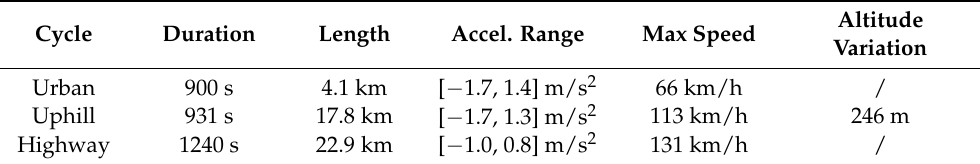
Figure 5. Speed profile of the highway real ‐ world drive mission. Table 4. Real ‐ world drive mission main characteristics.